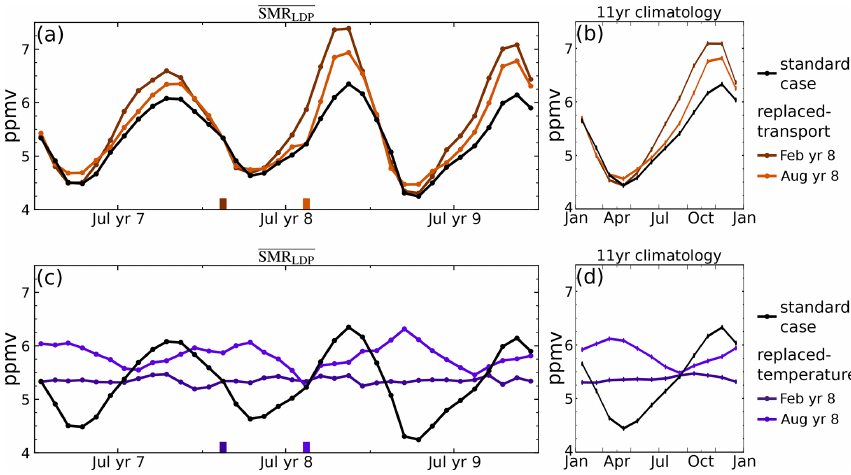
Figure 11. As for Fig. 5 but for the climate model. Time series of SMR LDP for 3 years of the UM-UKCA standard case (black line), (a) replaced-transport time series with wind field initialised to a fixed month of year 8 (orange lines) and (b) equivalent average annual cycle over 1999–2009. Panels (c) and (d) as for panels (a) and (b) but for replaced-temperature time series with temperature field initialised to a fixed month of 2004 (purple lines). Line shade corresponds to particular months marked with ticks; see also legend.